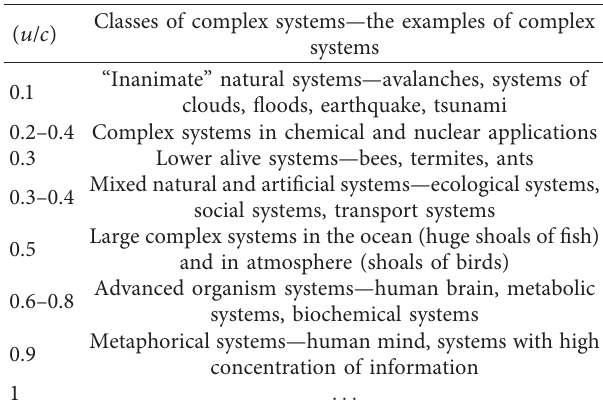
Table 1: Orientation values of ( u / c )